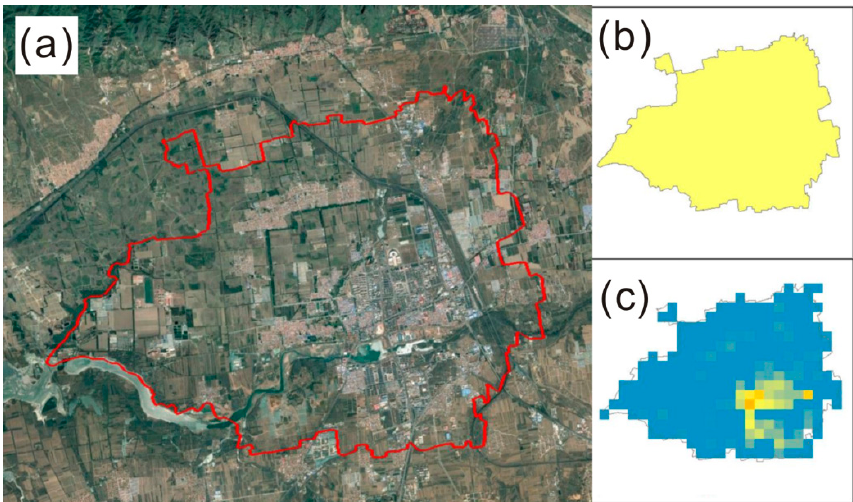
Figure 13. Comparison of the Google Earth image ( a ), census population data ( b ) and remotely-sensed population ( c ) in Yanqing Town. The red line in ( a ) is the boundary of the town. Figures b and c use the same legend as Figure 9.